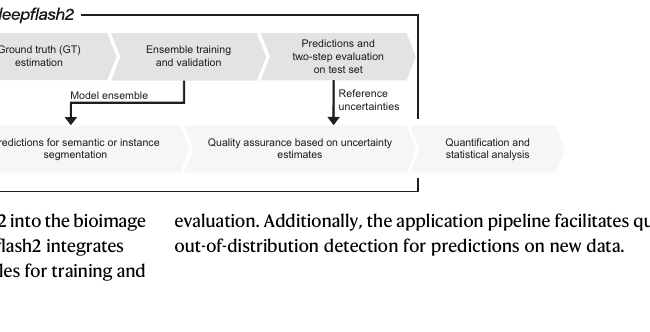
evaluation. Additionally, theapplication pipeline facilitatesquality monitoring and out-of-distribution detection for predictions on new